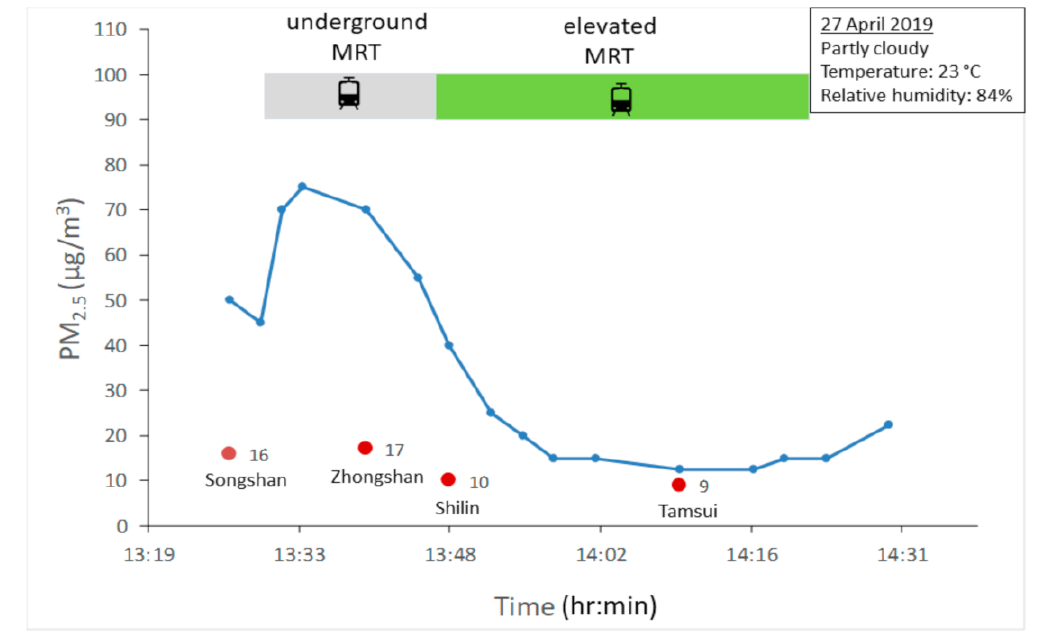
Figure 5. PM 2.5 concentrations during a trip that used an MRT line with underground and elevated